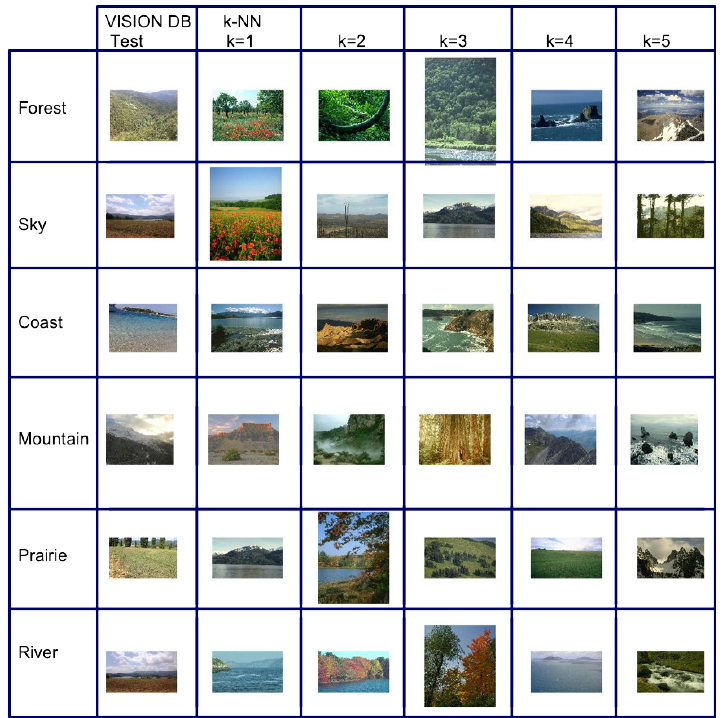
Figure 12. Image retrieval by scene on Shullani database